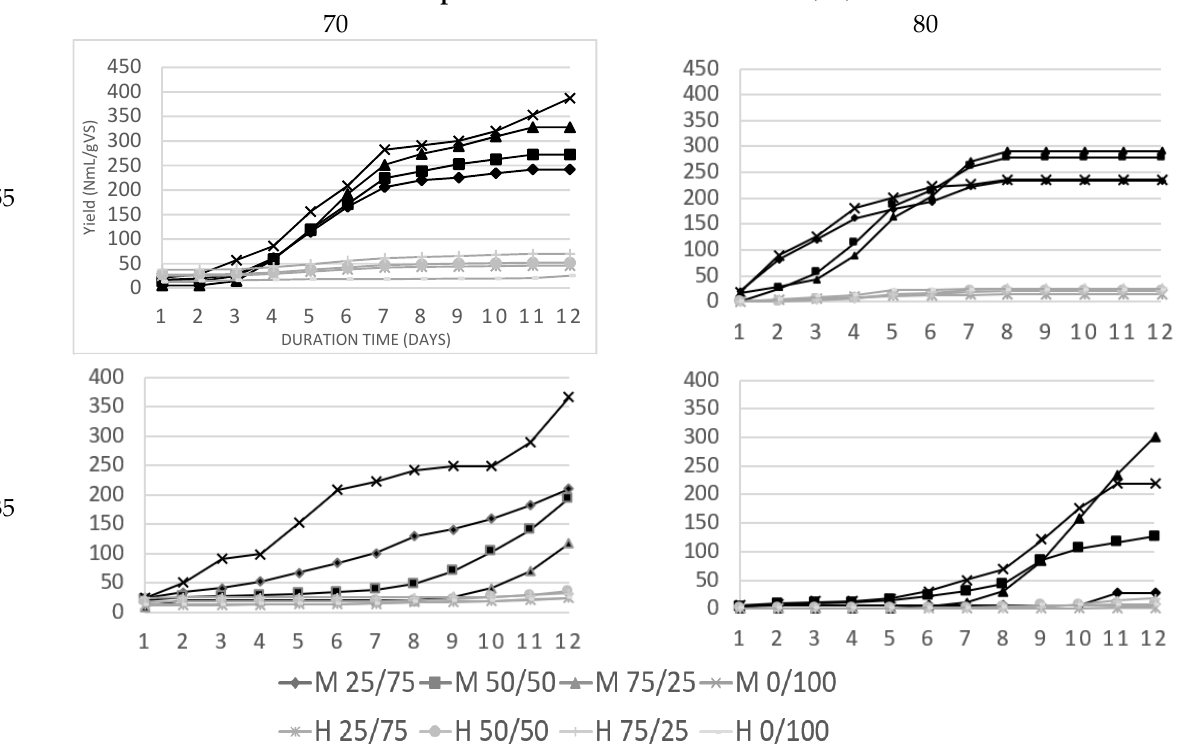
Figure 2. Cumulative methane and hydrogen yields from co-digestion of kitchen waste and leaves after hyperthermophilic pretreatment. M 25/75—mesophilic co-digestion of pretreated leaves with 25% addition of kitchen waste. M 50/50—mesophilic co-digestion of pretreated leaves with 50% addition of kitchen waste. M 75/25—mesophilic co-digestion of pretreated leaves with 25% addition of kitchen waste. M 0/100—mesophilic mono-digestion of pretreated leaves. T 25/75—thermophilic co-digestion of pretreated leaves with 25% addition of kitchen waste. T 50/50—thermophilic co-digestion of pretreated leaves with 50% addition of kitchen waste. T 75/25—thermophilic co-digestion of pretreated leaves with 25% addition of kitchen waste. T 0/100—thermophilic mono-digestion of pretreated leaves.